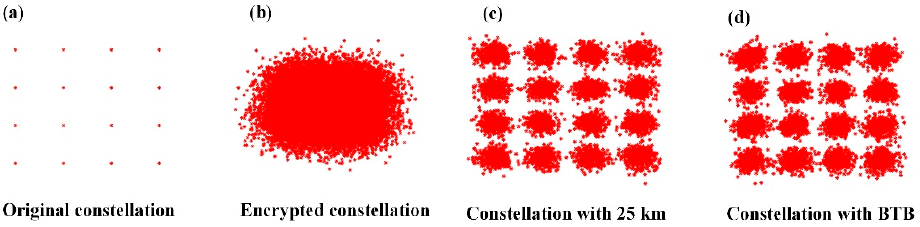
Figure 11. Constellation diagram for different scenarios. ( a ) the original constellation diagram, ( b ) the encrypted data constellation diagram, ( c ) the restored constellation diagram after 25 km optical fiber transmission, and ( d ) the restored constellation diagram after BTB.